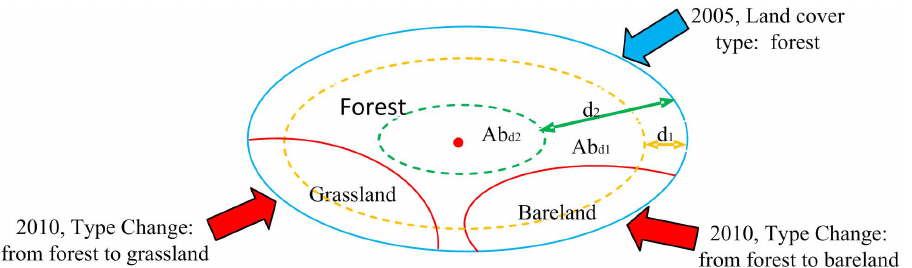
Figure 7. Sketch map of automatic dataset of pure-pixel training samples. Figure S1 Comparison of land cover classification of region with much land cover change (Anshan): (a) TM image of 2010;(b) land cover of 2005;(c) land cover of 2010 from visual interpretation; (d) land cover classified by our method. Figure S2 Comparison of land cover classification of region with normal land cover change degree (Neijiang): (a) TM image of 2010;(b) land cover of 2005;(c) land cover of 2010 from visual interpretation; (d) land cover classified by the proposed method. Figure S3 Comparison of land cover classification around Shuangtaihe natural conservation region: (a) TM image of 2010;(b) land cover of 2005;(c) land cover of